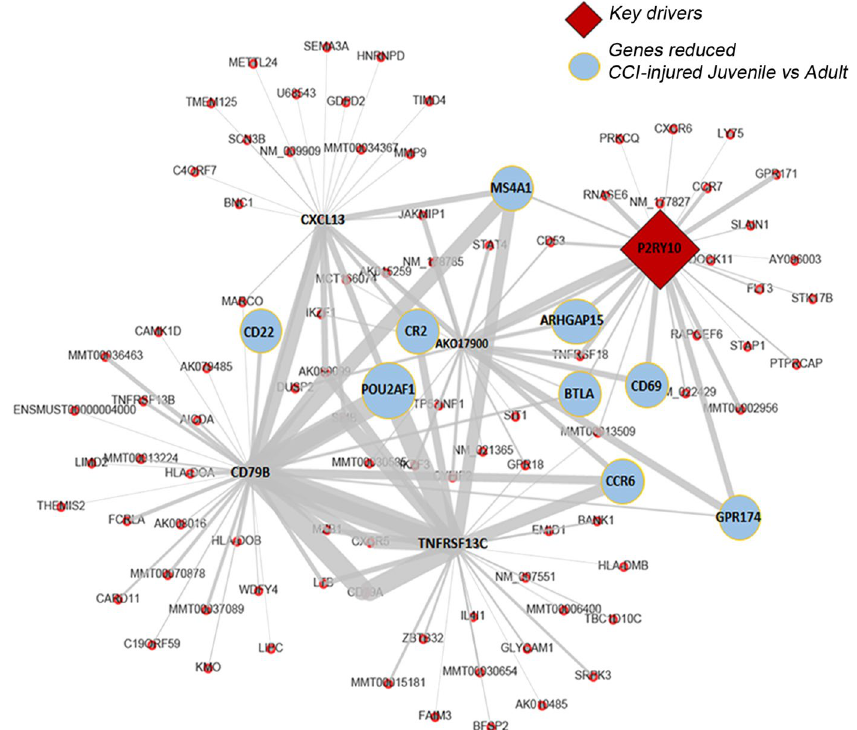
Figure 3. P2ry10 is a key driver of the juvenile gene profile following CCI injury. Mergeomics analysis of differentially reduced genes in juvenile vs adult CCI-injured mouse peripheral blood identified significant interactions between genes and identified P2ry10 as a key driver implicated in the genes found to be reduced in the juvenile peripheral immune response to injury. Red diamond, key driver; Blue circles, reduced juvenile genes; red dots, other known neighboring genes within the